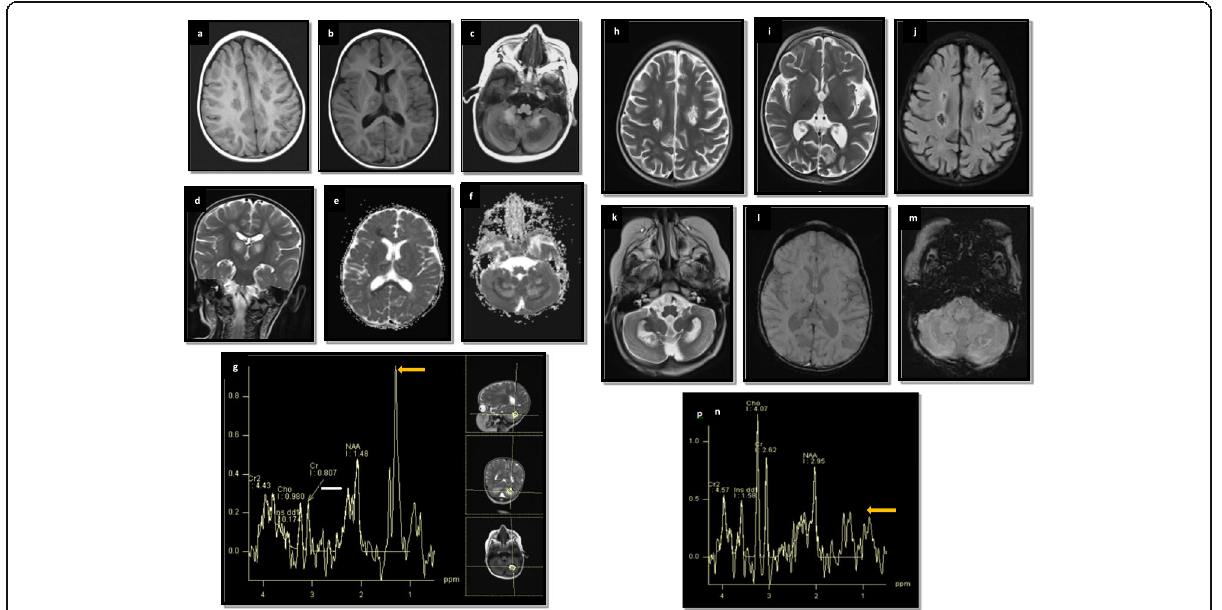
Fig. 1 Multi-parametric MRI dynamic changes of the brain of a 1-year-old patient who was left with marked sequelae. He presented with behavior changes, abnormal movement, and agitation and was diagnosed with ANEC. At the onset of the disease, a , b , and c axial T1 WI, d coronal T2 WI show lesions on bilateral thalamic, basal ganglia (caudate nucleus), WM cerebral parenchyma (corona radiata), and WM cerebellar parenchyma being low signal in T1WI with small focus in the center of the thalamic lesions, high signal in T2WI. e and f Axial ADC shows typical tricolor pattern of thalamic lesions being high signal at the center, low surrounding signal, and bright peripheral signal; these also seen at cerebellar WM lesion. g Single-voxel MR spectrogram (TE, 115) of cerebellar WM lesion shows increased glutamate/glutamine complex peak intensities at 2.3ppm and lipid/lactate complex peak intensities at 1.2ppm, with reduced NNA peak at 2ppm. Follow-up after 4weeks, h and i axial T2 WI, j and k FLAIR images, and reveal disappearance of WM cerebral lesions, generalized atrophy of the cerebral hemispheres, with widened ventricular size, impressive regression of the thalamic and cerebellum lesions being replaced by encephalomalacia surrounded by gliosis. l and m SWI shows hemosiderin deposition in the bilateral thalami and the cerebella (red arrow). n MRS shows dramatic reduction of the lactate peak (arrow) and the NAA peak returns within the normal